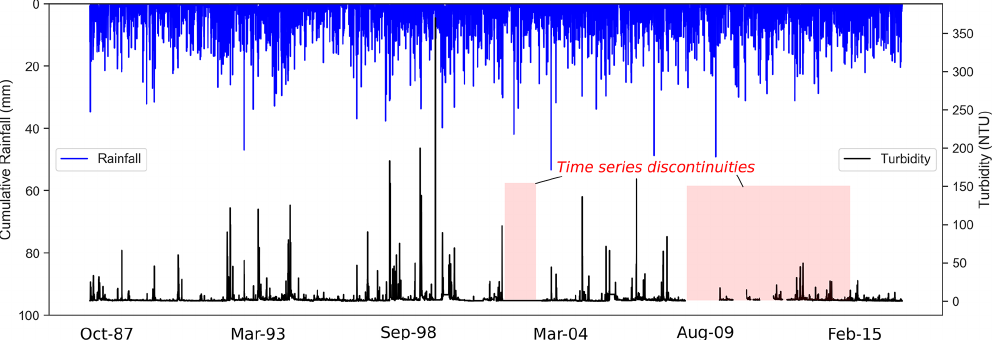
Figure 2. Cumulative daily rainfall (mm) extracted from the SAFRAN database over the Radicatel hydrogeological catchment and maximum daily turbidity (NTU) observed at the water treatment plant from 1987 to